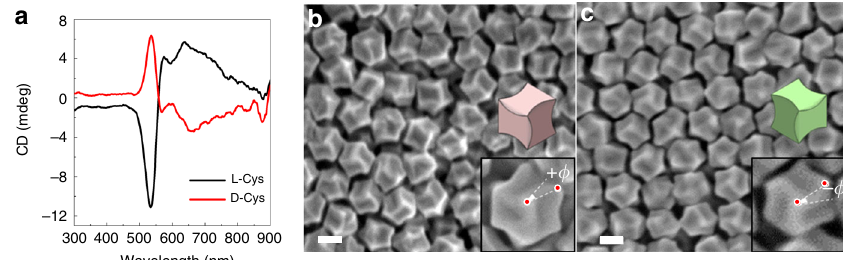
Fig. 1 Opposite handedness of chiral nanoparticles depending on the cysteine enantiomer. a Circular dichroism (CD) spectra of nanoparticles synthesized using L-cysteine (L-Cys, black) and D-cysteine (D-Cys, red). SEM images of resultant chiral nanoparticles obtained using L-Cys ( b ) and D-Cys ( c ). Schematic models and magni fi ed SEM images are shown in the inset. Auxiliary lines indicating oppositely bent edges at an angle of + ϕ for L-Cys and − ϕ for D-Cys are illustrated in the SEM images. Scale bar,